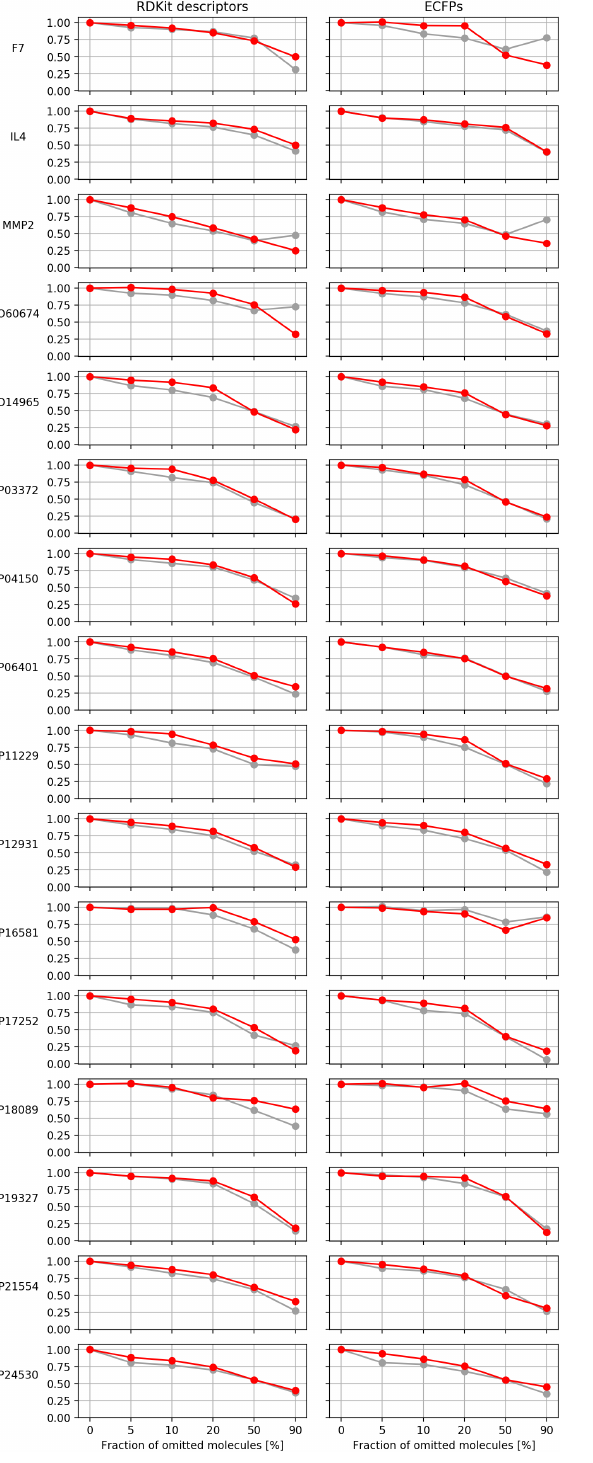
Figure 6. MSE s for different fractions of omitted predictions for all datasets. The label of the corresponding dataset of each plot is denoted left to the y -axis. MSE s when removing predictions according to the SDEP are shown in gray. MSE s obtained by removing predictions using HVLs are depicted in red. For each evaluation, the six connected points correspond to the MSE when leaving out the least certain 0%, 5%, 10%, 20%, 50%, and 90%, as denoted by the x -axis. All values within each evaluation were divided by the total MSE involving all predictions ( MSE 0 ) to aid visual comparison. The numbers on each y -axis are, therefore, fractions of MSE 0